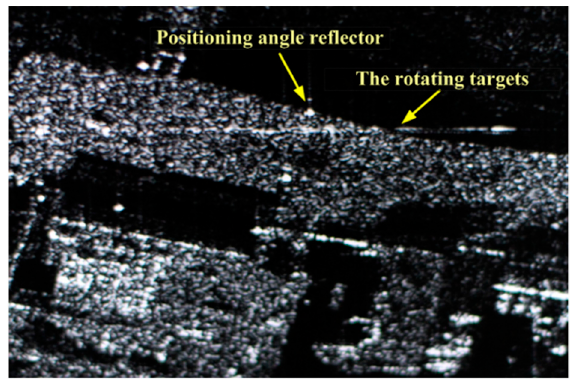
Figure 13. SAR image result of the scene.